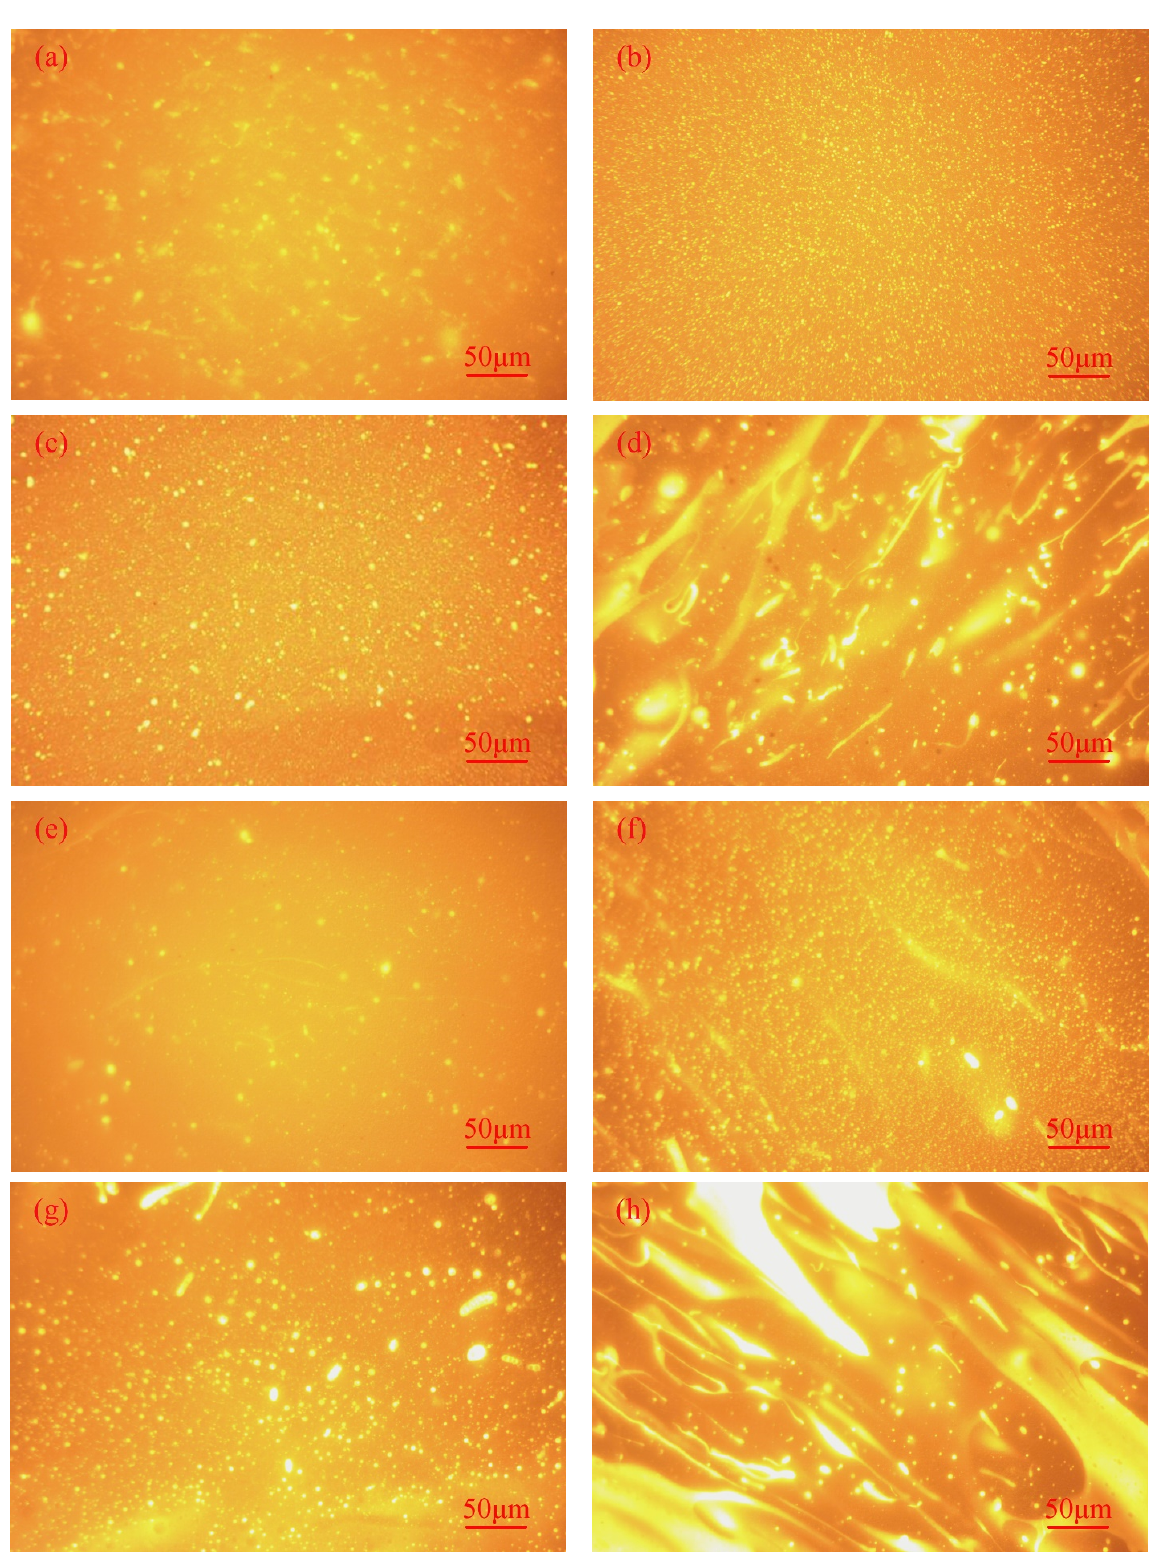
Figure 11. Fluorescence microscopy of different HVA: ( a ) EHVM-8; ( b ) EHVM-12; ( c ) EHVM-16; ( d ) EHVM-20; ( e ) TPS-8; ( f ) TPS-12; ( g ) TPS-16; ( h ) TPS-20.